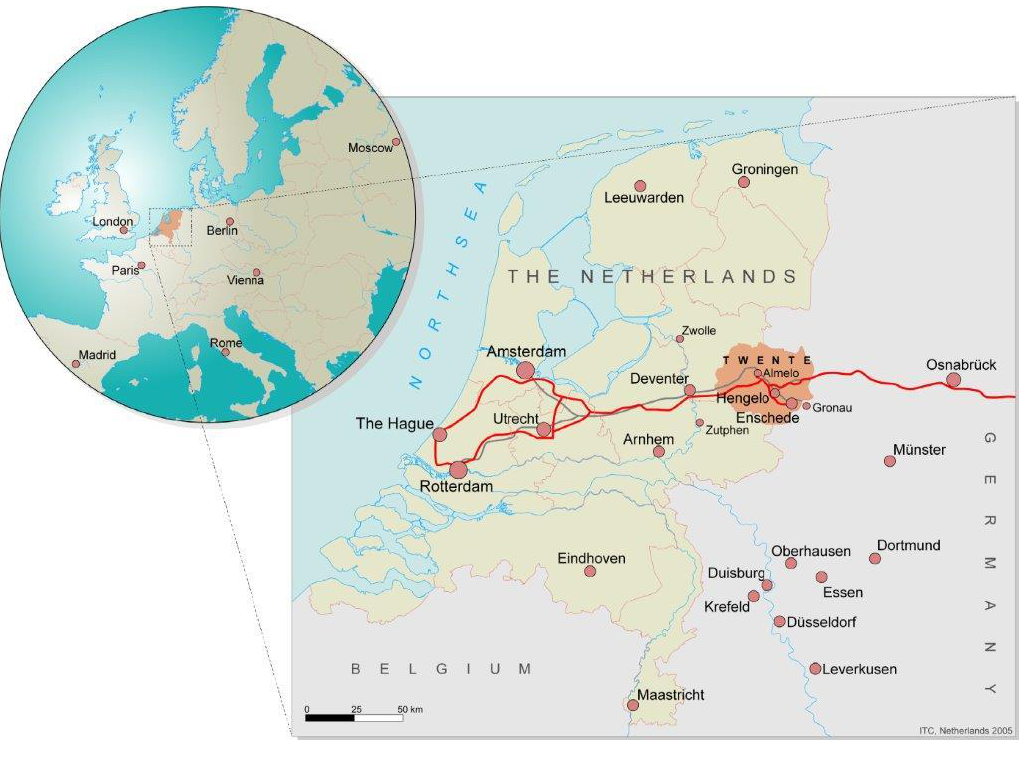
Figure 3. The Twente region. Source: : ITC, 2005 (Courtesy of Faculty ITC, University of Twente) Soc. Sci. 2018 , 7 , x FOR PEER REVIEW